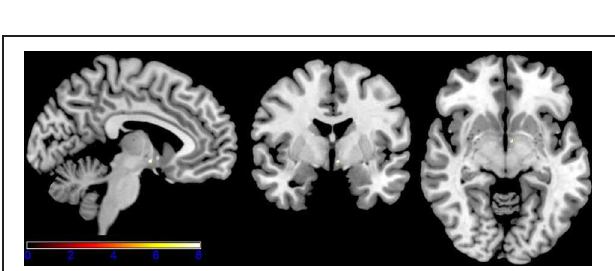
FIGURE 5 | Shown are sagittal, coronal, and axial slices overlaid with activity clusters corresponding to the interaction effect related to the two sessions and emotional categories ( p < 0 . 001 uncorrected for whole-brain volume analysis; for a more detailed description of activated brain regions, please see Table 1).